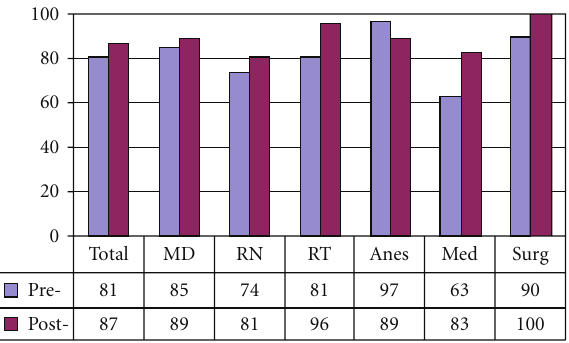
Figure 4: Laryngectomy patients have no nasal/oral airway (% Correct).